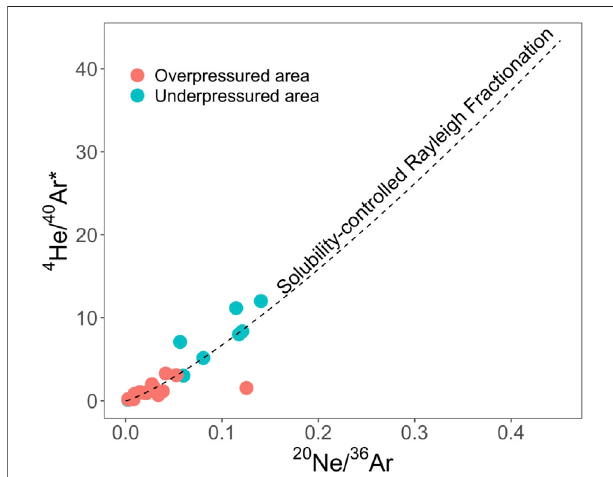
FIGURE 7 | A plot of atmosphere-derived 20 Ne/ 36 Ar vs. crustal radiogenic 4 He/ 40 Ar*. The dashed line is a solubility-controlled Rayleigh fractionation modeling line for all gas samples in San Juan Basin (Zhou et al.,